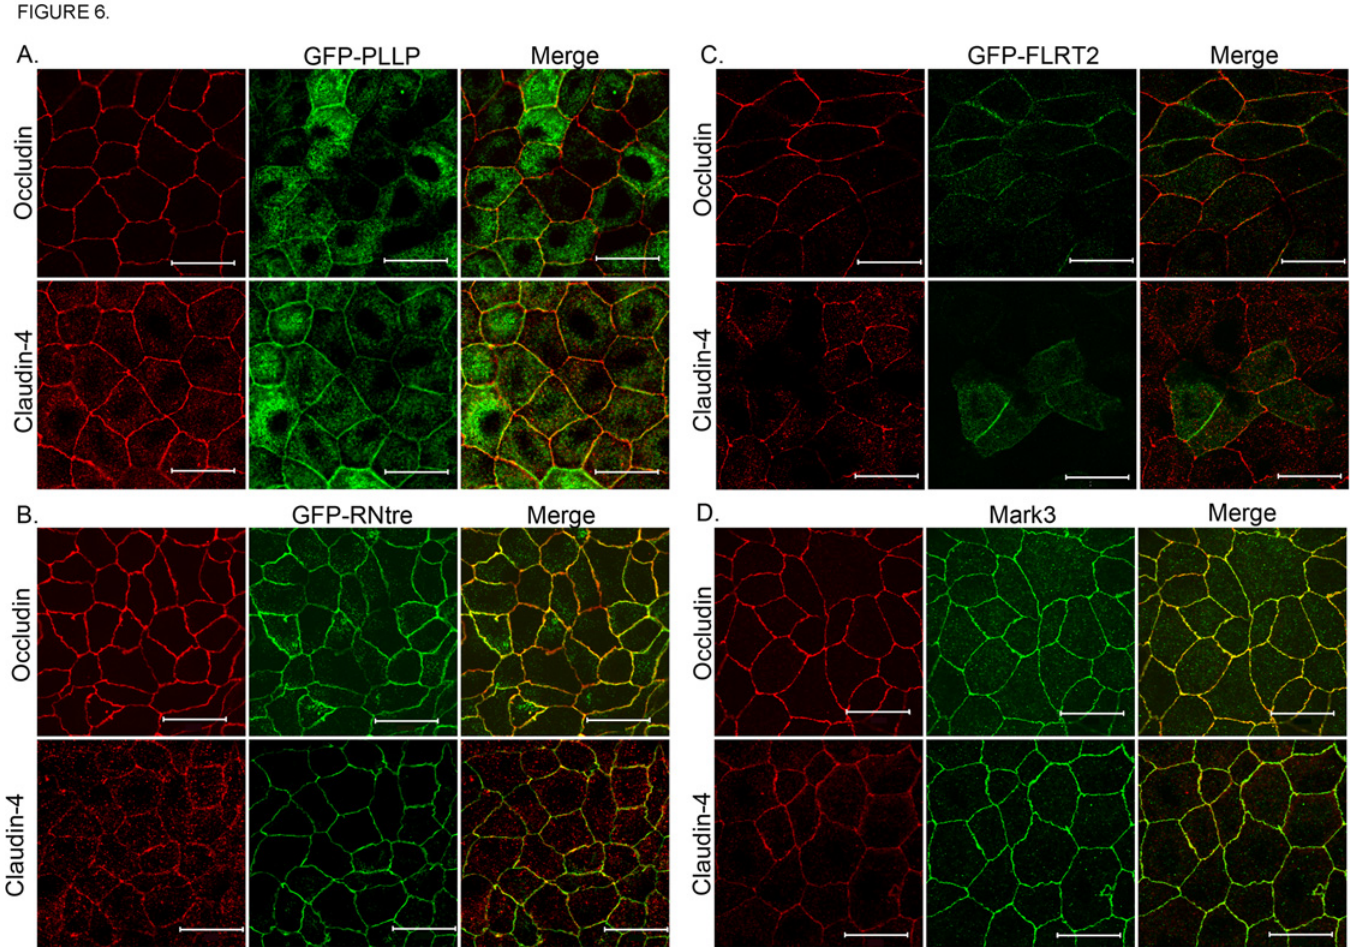
Fig 6. Cellular localization of proteins identified by proteomic analysis of proteins surrounding occludin and claudin-4. A . GFP-PLLP localizes diffusely in the cytoplasm and at cell-cell contacts (two middle panels). Co-localization with Ocln and Cldn4 appears to be at cell-cell contacts (two right panels). B . GFP-RNtre predominantly localizes to cell-cell contacts (two middle panels) where the co-localization with Ocln and Cldn4 occurs (two right panels). C . GFP-FLRT2 localizes diffusely in the cytoplasm and at cell-cell contacts (two middle panels).Co-localization with Ocln and Cldn4 appears to be at cell-cell contacts (two right panels). D . The majority of Mark3 localizes to cell-cell contacts but is also present in punctate structures in the cytoplasm (two middle panels). Ocln and Cldn4 co-localize with Mark3 at cell-cell contacts (two right panels). Bar, 20 microns (x63 oil